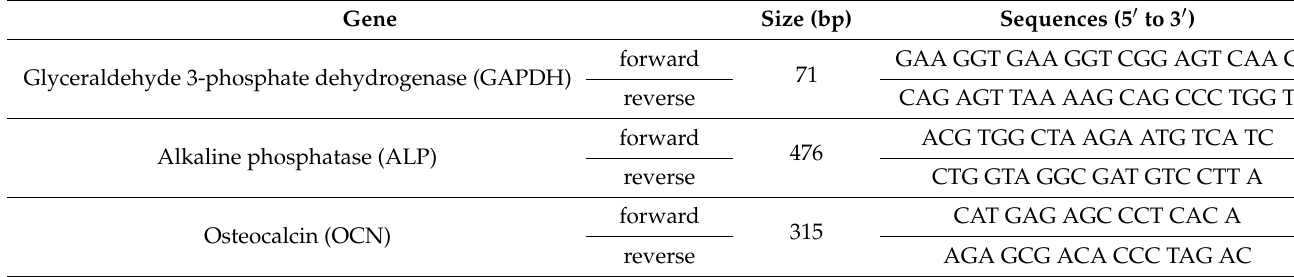
Table 2. Primers used in qPCR to evaluate the osteogenic differentiation of human mesenchymal stem cells (hMSCs). Gene Size (bp)